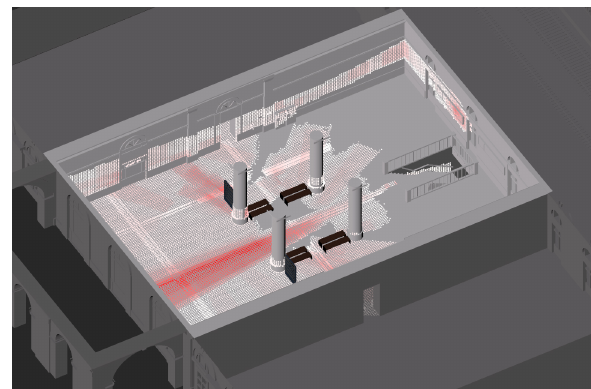
Figure 8. Axonometric representation of the results.